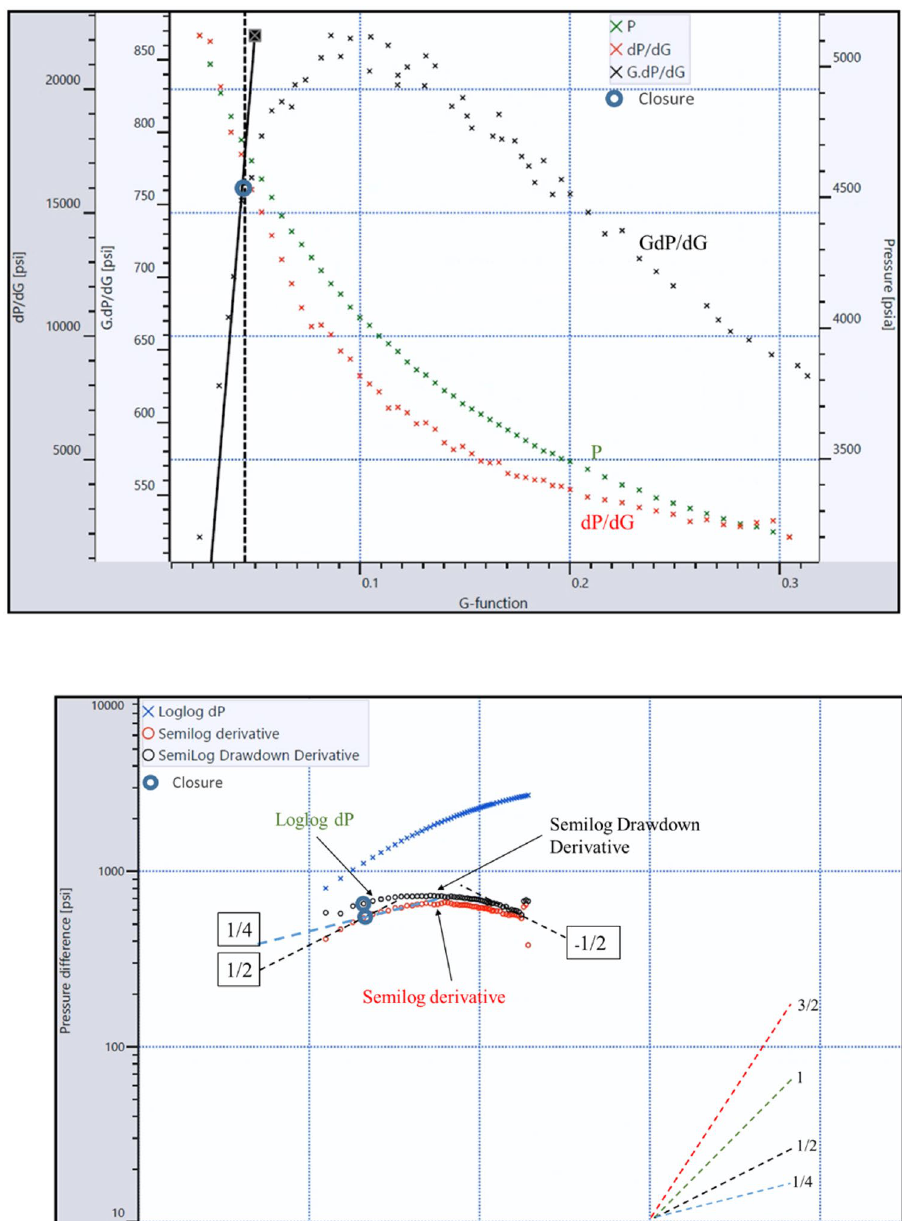
Fig. 20 A G-function plot for the simulation with no natural fracture. The closure pressure is 4600 psi which is equal to the minimum principal stress in the simulation